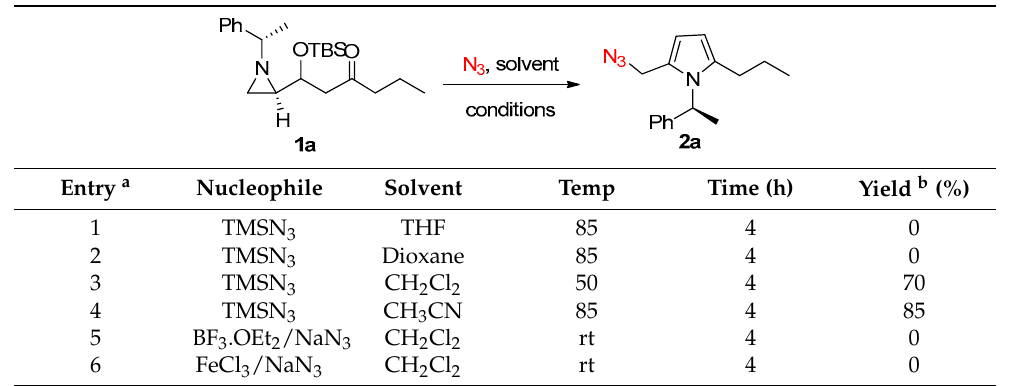
Table 1. Optimization of the reaction conditions.